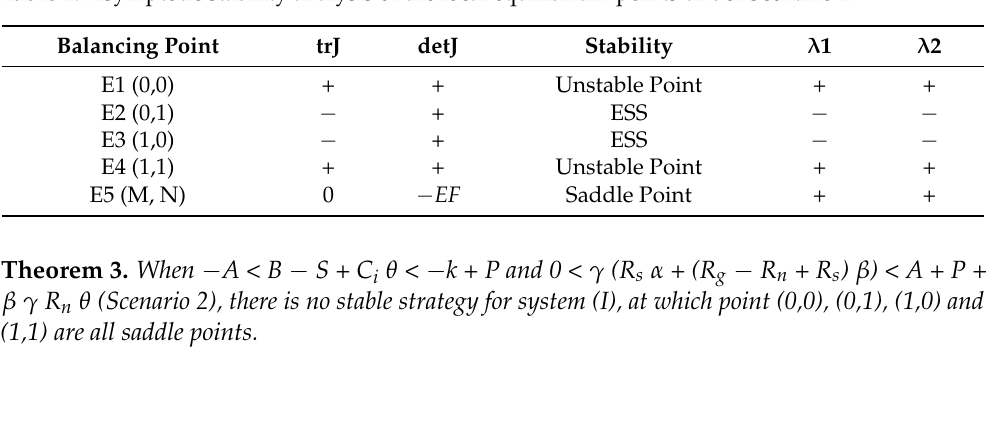
Table 4. Asymptotic stability analysis of the local equilibrium points under Scenario